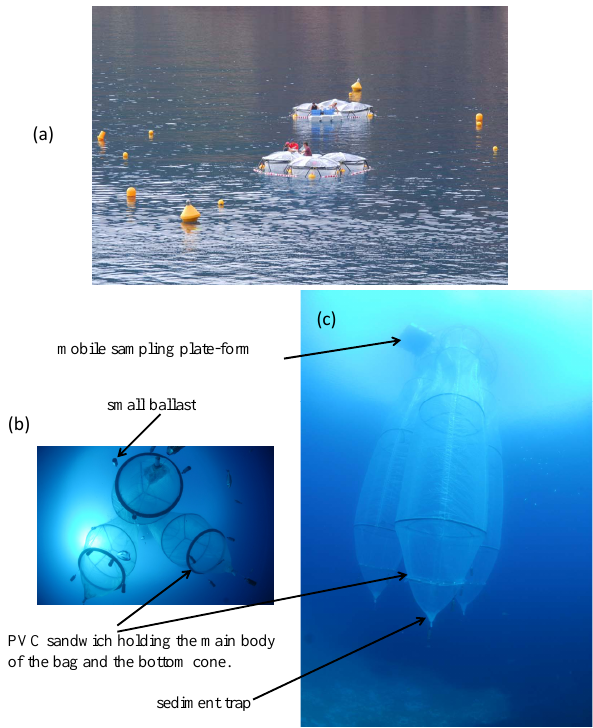
Fig. 10. (a) A view of the experiment from above: the two platforms in open waters separated by a few meters. At mid-distance between the two platforms is the position where the “OUTSIDE” sampling was performed. (b) A view from the seafloor showing the bases of three mesoscosms, in particular one can see the junction between the main body of the bag and the bottom cone created by the PVC sandwiches (photo: David Luquet, OOV). (c) A view from below, (from the side), of a group of three mesocosms; the seafloor is 10m below the base of the mesocosms. At the surface, the plastic mo- bile platform moved temporarily close to the structure for sampling every day. At the base of the bags: the small sediment